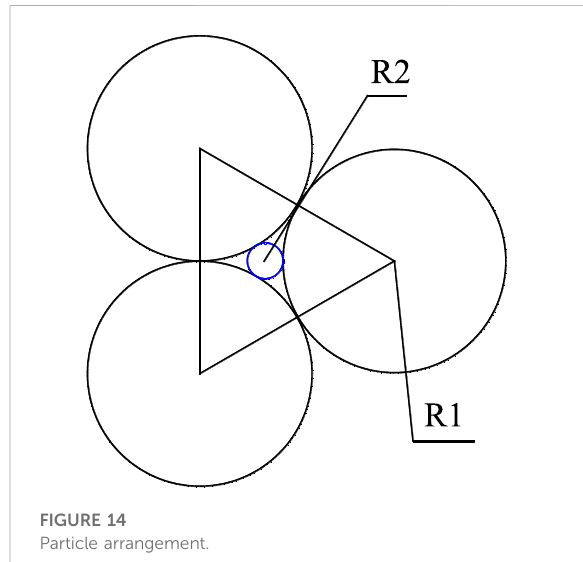
FIGURE 14 Particle arrangement.